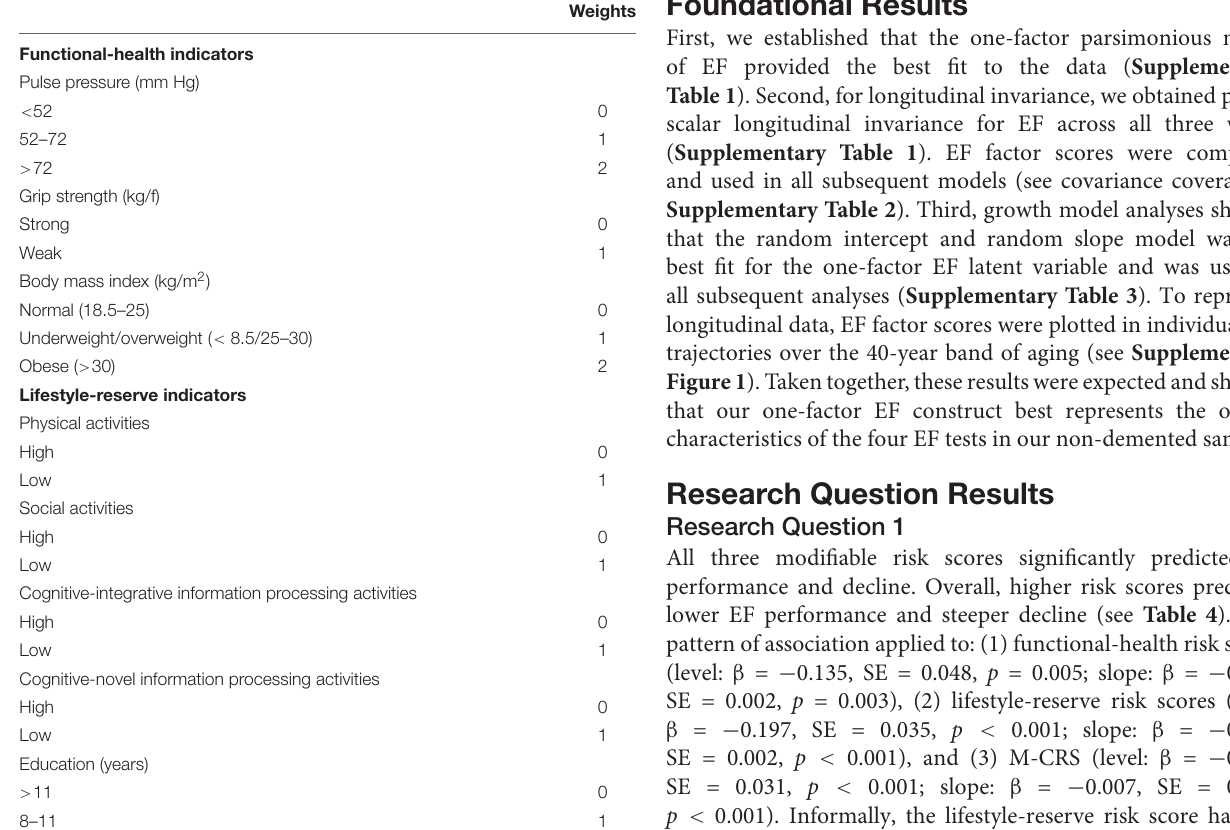
TABLE 3 | Weights assigned to calculate risk scores for functional-health and lifestyle-reserve domains.